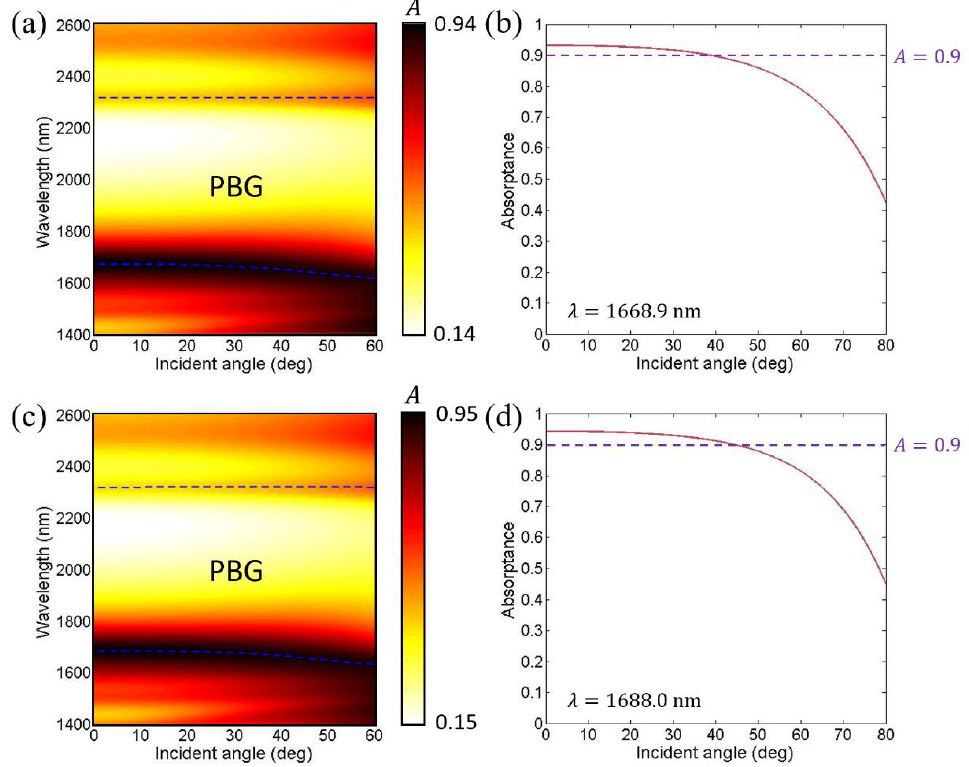
Figure 8. ( a ) Absorptance spectrum of the 1-D PCCH [(EF) 2 D] 6 as a function of the incident angle under TM polarization when 𝑑′ C = (1 − 5%)𝑑 C and 𝑑′ D = 𝑑 D . ( b ) Absorptance of the 1-D PCCH [(EF) 2 D] 6 as a function of the incident angle at the short-wavelength angle-insensitive band edge 𝜆 = 1668.9 nm under TM polarization when 𝑑′ C = (1 − 5%)𝑑 C and 𝑑′ D = 𝑑 D . ( c ) Absorptance spectrum of the 1-D PCCH [(EF) 2 D] 6 as a function of the incident angle under TM polarization when